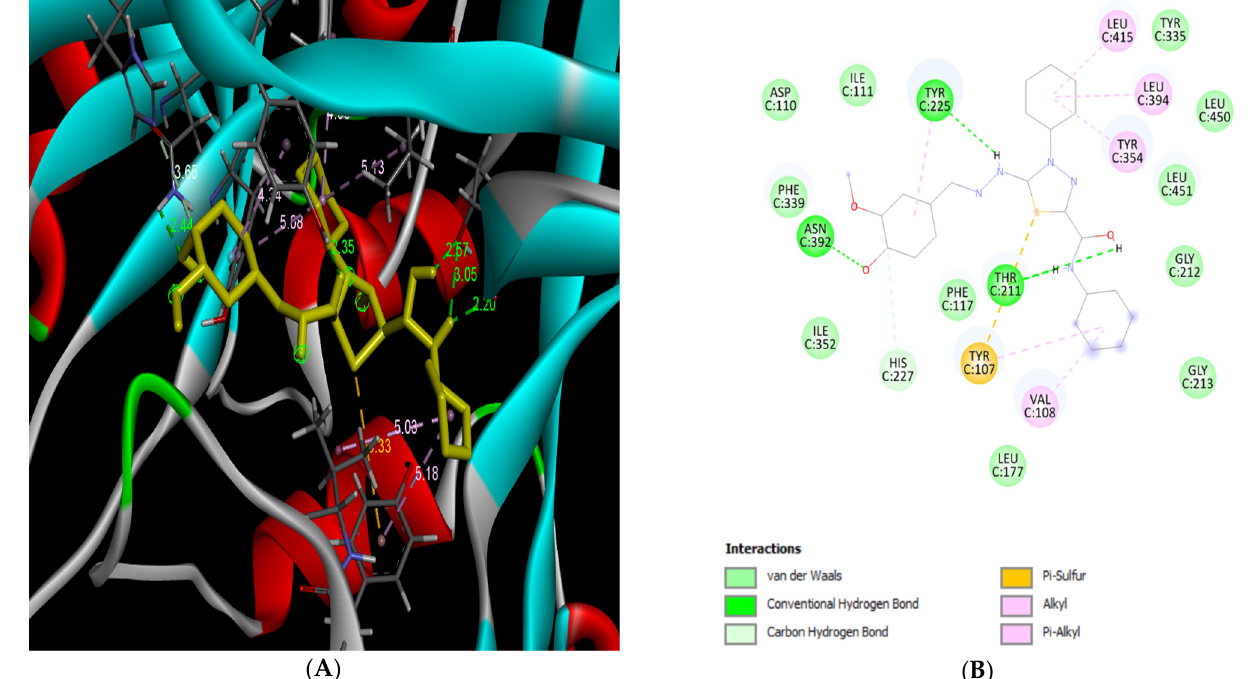
Figure 7. 2D ( B ) and 3D ( A ) representation of compound 3 docking with Nmt.